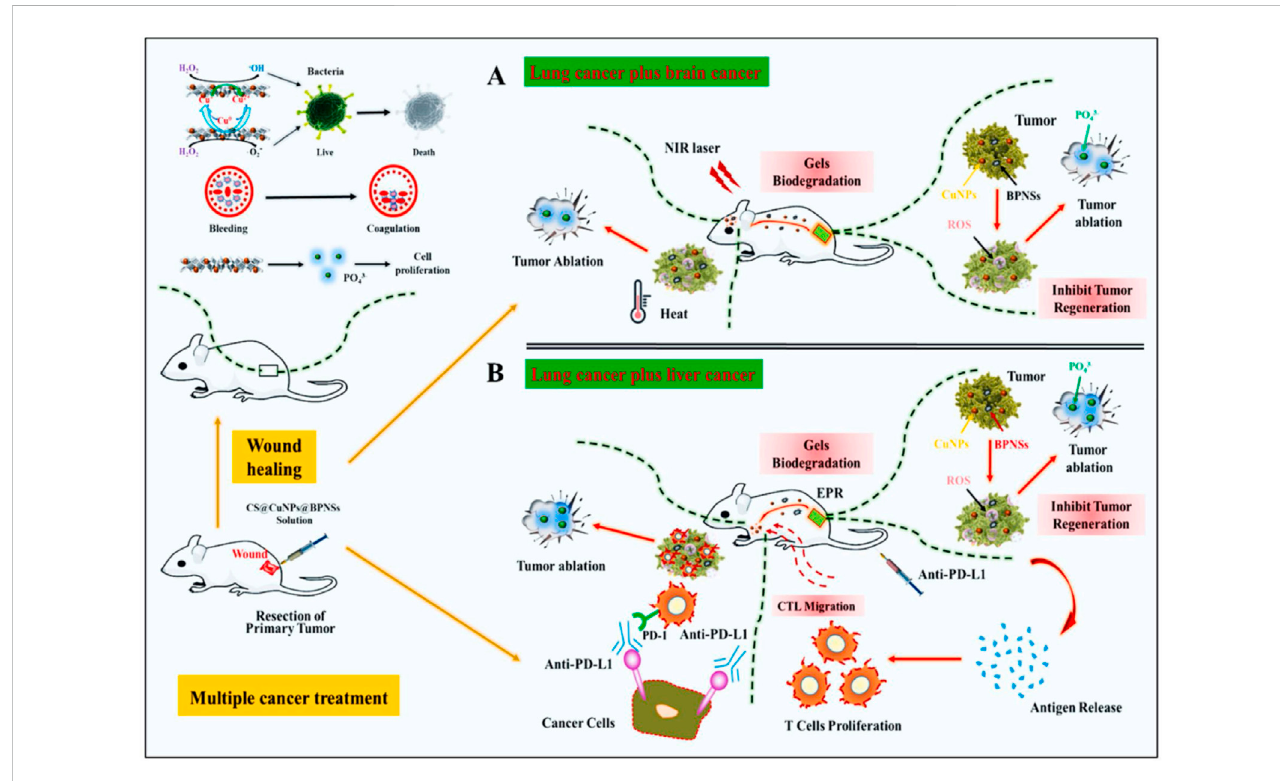
FIGURE 2 Illustration of the therapeutic mechanism of the hydrogel in inhibition of multiple cancer growth (A) Lung cancer with brain cancer (B) Lung cancer with liver cancer (Wang et al.,